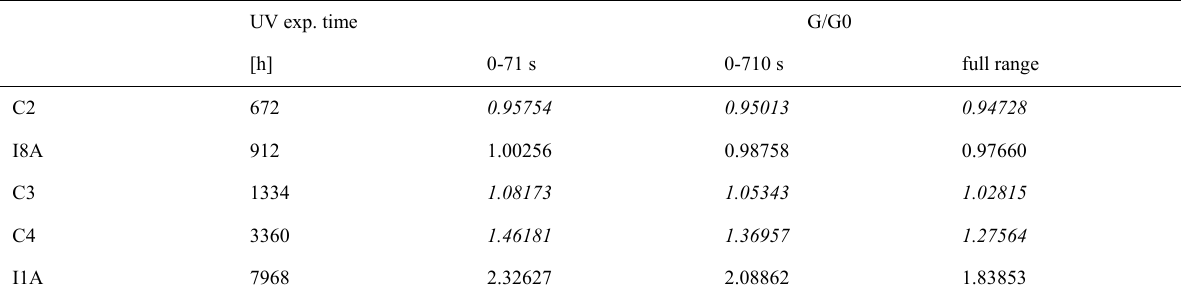
Table 2. Alteration parameter computed on specimens I8A and I1A, extrapolated for specimen C2 and interpolated for specimens C3 and C4 (italics)